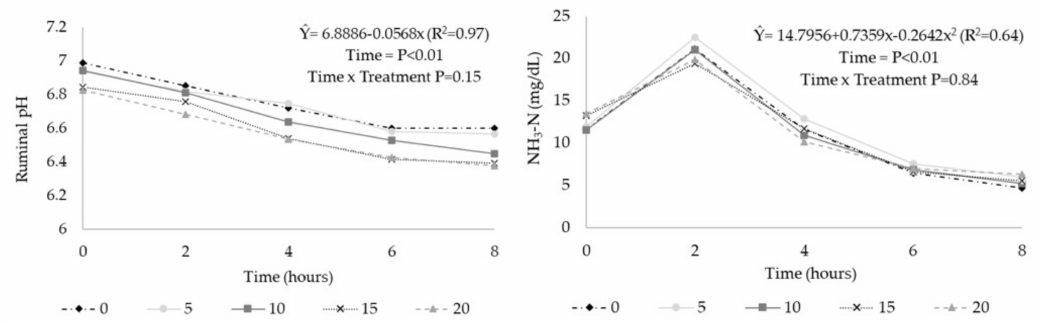
Figure 1. Ruminal values of pH and ammonia nitrogen (NH 3 -N) in steers receiving diets with condensed tannins extract (CT) from Acacia mearnsii, as a function of time after feeding. 0 = no CT inclusion; 5 = 5 g of CT / kg of dry matter (DM); 10 = 10 g of CT / kg of DM; 15 = 15 g of CT / kg of DM; 20 = 20 g of CT / kg of DM.